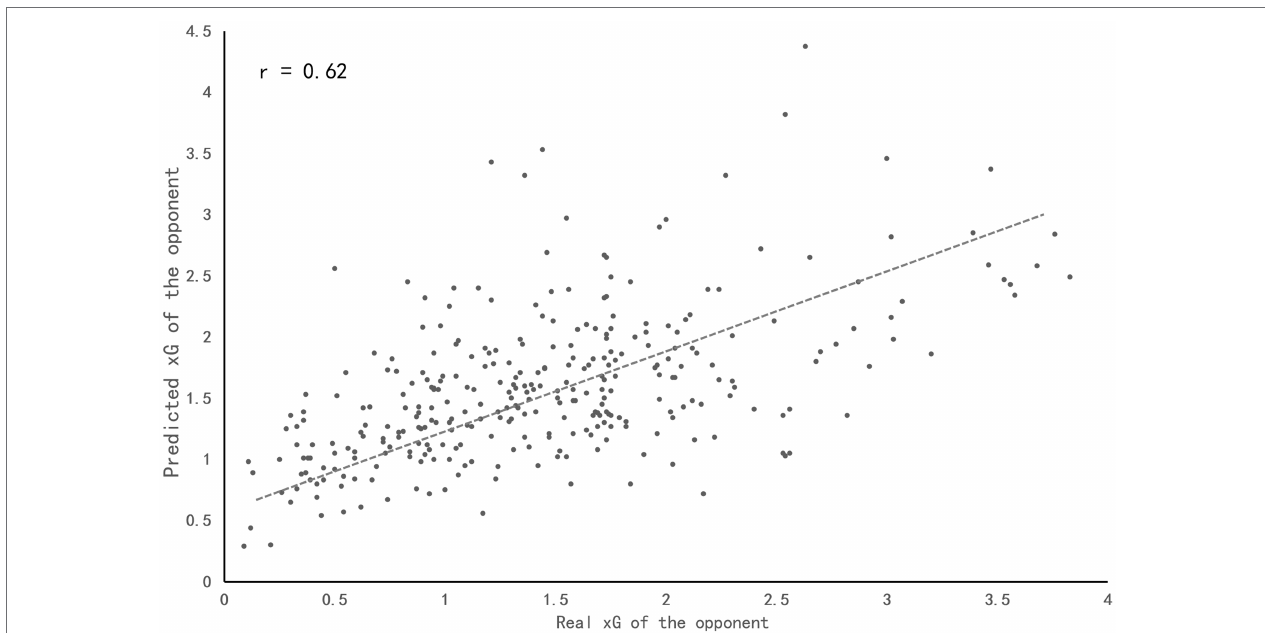
FIGURE 4 | Correlation between the actual and predicted xG of the opponent of 2020 season in CSL. Each dot represents one team in a match, for a total of 320 real-predicted comparisons. The dotted line represents the trend of correlation between the actual and predicted xG of the